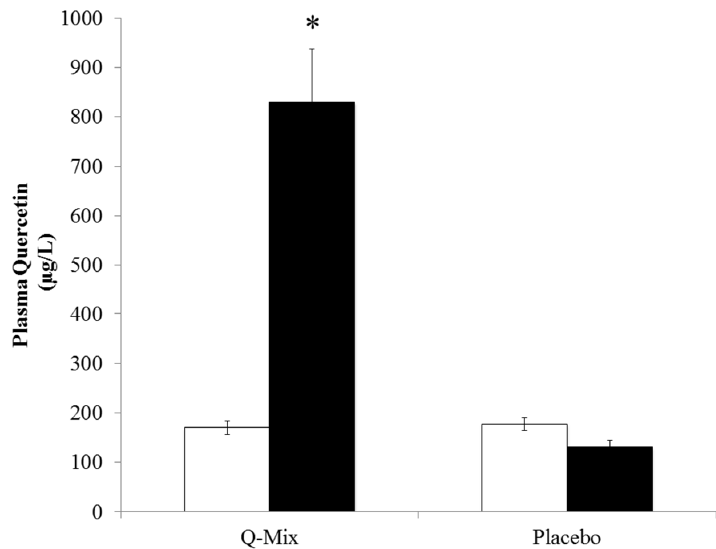
Figure 1. Plasma quercetin levels by supplement groups at pre ‐ ( □ ) and post ‐ ( ■ ) supplementation. Participants were randomly assigned to either placebo (0-mg/day of isoquercetin, EGCG, and n 3-PUFA) or Q-Mix (400 mg isoquercetin, 120 mg ECGC, and 400 mg n 3-PUFAs containing vitamin C and niacin). Error bars represent SE. Significance test was based on two ‐ way ANOVA (group and time). * Plasma quercetin levels increased with Q-mix ( p < 0.001) from pre- to post-supplementation compared to placebo.